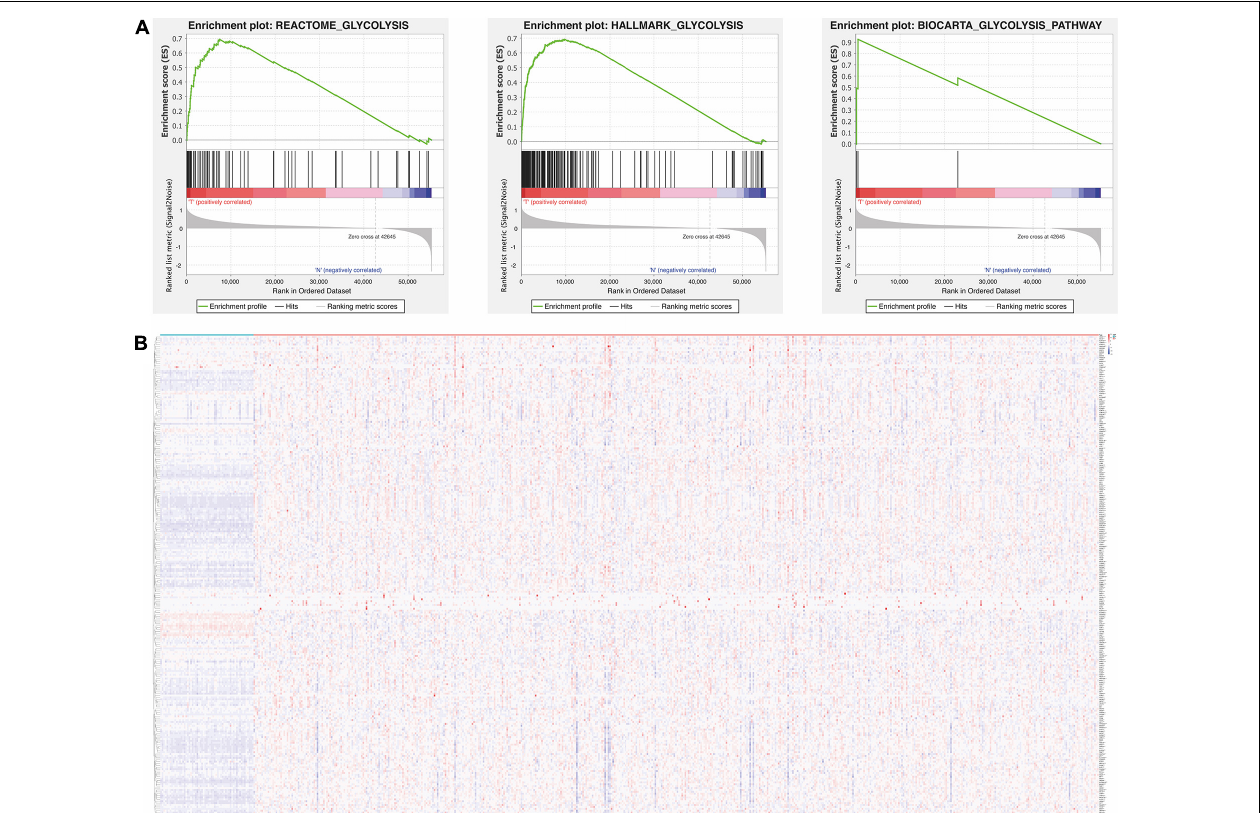
FIGURE 1 | Relationship between glycolysis and tumorigenesis in LUAD. (A) Enrichment plots of three gene sets which were differentiated between in LUAD and normal tissues via GSEA, p < 0.05 was considered to be statistically significant. (B) The expression level of 255 glycolysis-related genes in LUAD and normal tissues. Red is up-regulated and blue is down-regulated. Genes are in rows; samples are in columns. LUAD, lung adenocarcinoma; GSEA, gene set enrichment analysis.